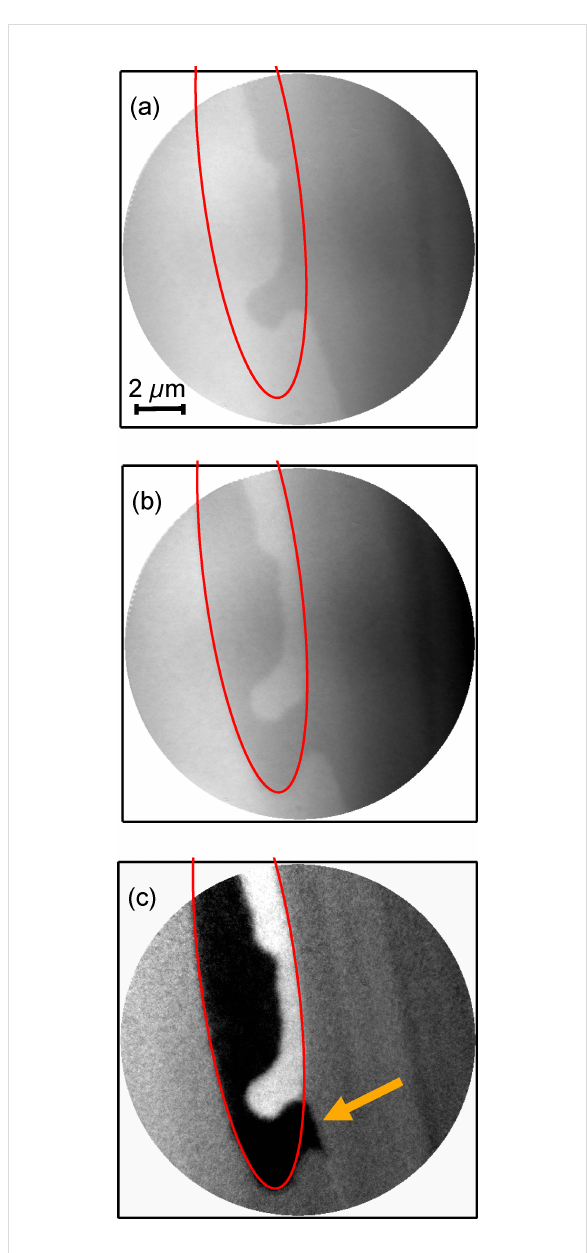
Figure 1: Static XMCD-PEEM images acquired at 50 K before (a) and after (b) a single laser pulse of 6.8 mJ/cm 2 fluence in the center. Light and dark gray contrast corresponds to opposite magnetization direc- tions. (c): Difference image (image (b) minus image(a)). The red ellipse marks a line of constant fluence equaling the threshold fluence for all- optical toggle switching. The yellow arrow indicates a position at which a deviation from the deterministic toggle switching is